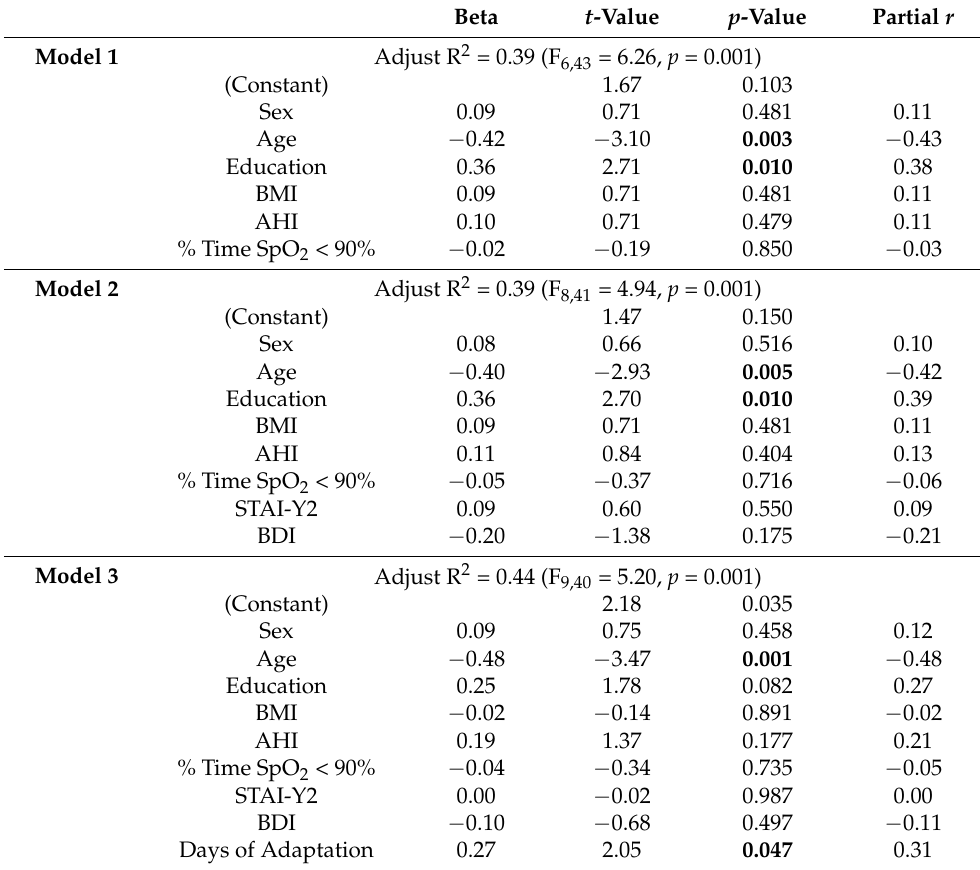
Table 4. Results of the hierarchical multiple linear regression analysis investigating the possible predictors of the consistency of long-term memory retrieval (i.e., Selective Reminding Test—CLTR score). Adjusted R 2 and F-statistics are reported for each model. Standardized Beta, t -values, p -values, and partial r correlation coefficients are reported for each predictor in each model. BMI: body mass index; AHI: apnea-hypopnea index; % Time SpO 2 < 90%: cumulative time spent with peripheral blood oxygen saturation (SpO 2 ) below 90%; STAI-Y2: State-Trait Anxiety Inventory form Y2; BDI: Beck Depression Inventory. Bold means significant results ( p ≤